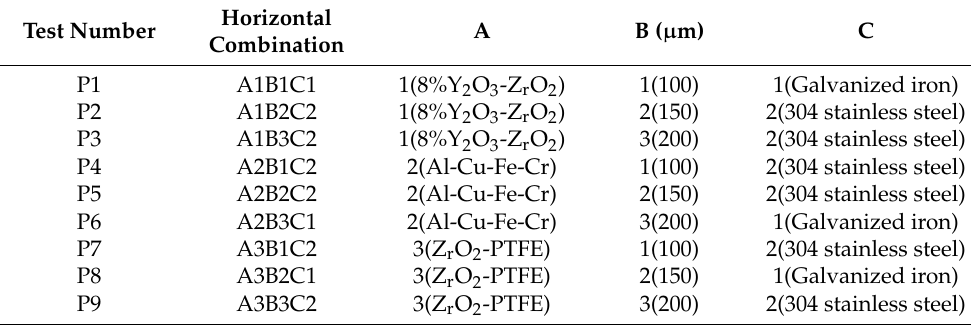
Table 2. Spraying experiment scheme.